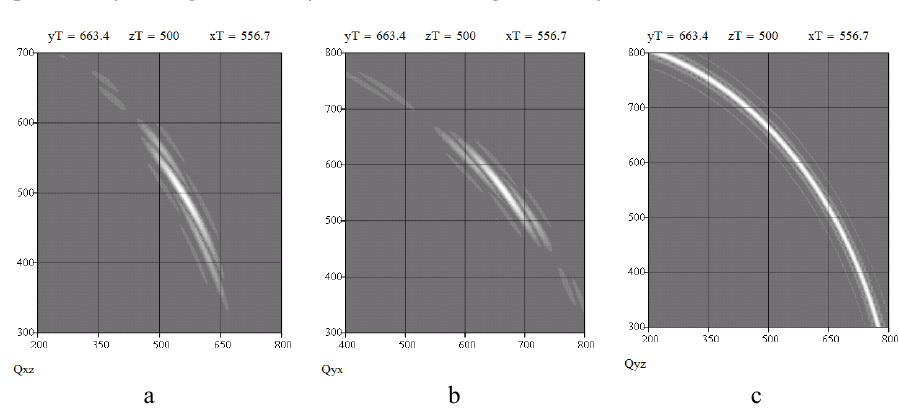
Fig. 3. Example of two-dimensional generalized ambiguity function cross-sections in Cartesian